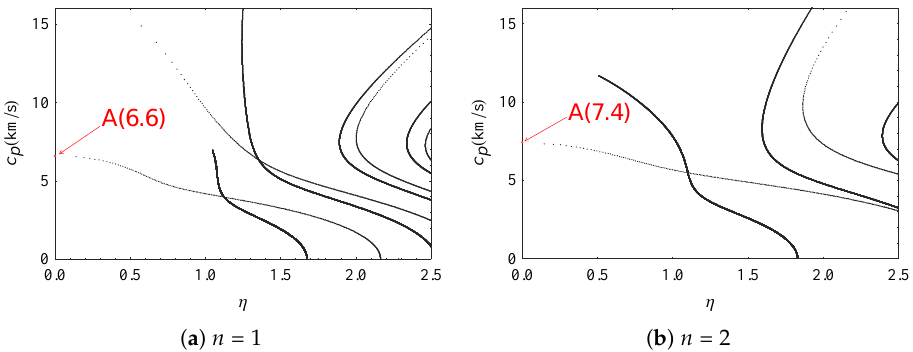
Figure 7. Phase velocity curves of loss decrements with different gradient coefficient n in FGPM